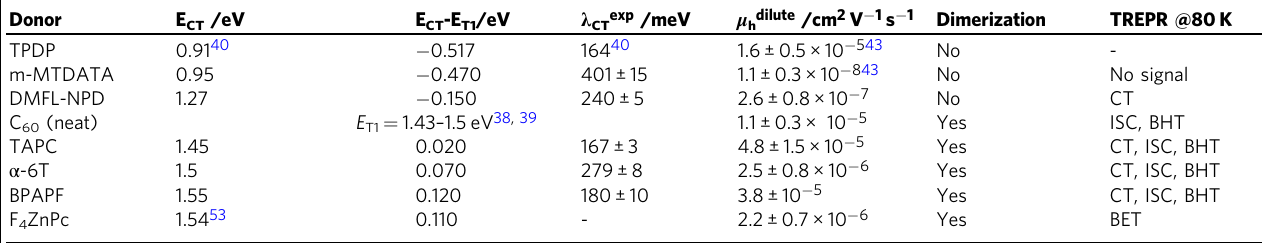
Table 1 Summary of the dilute blend properties obtained from sEQE and SCLC, and TREPR results. Donor